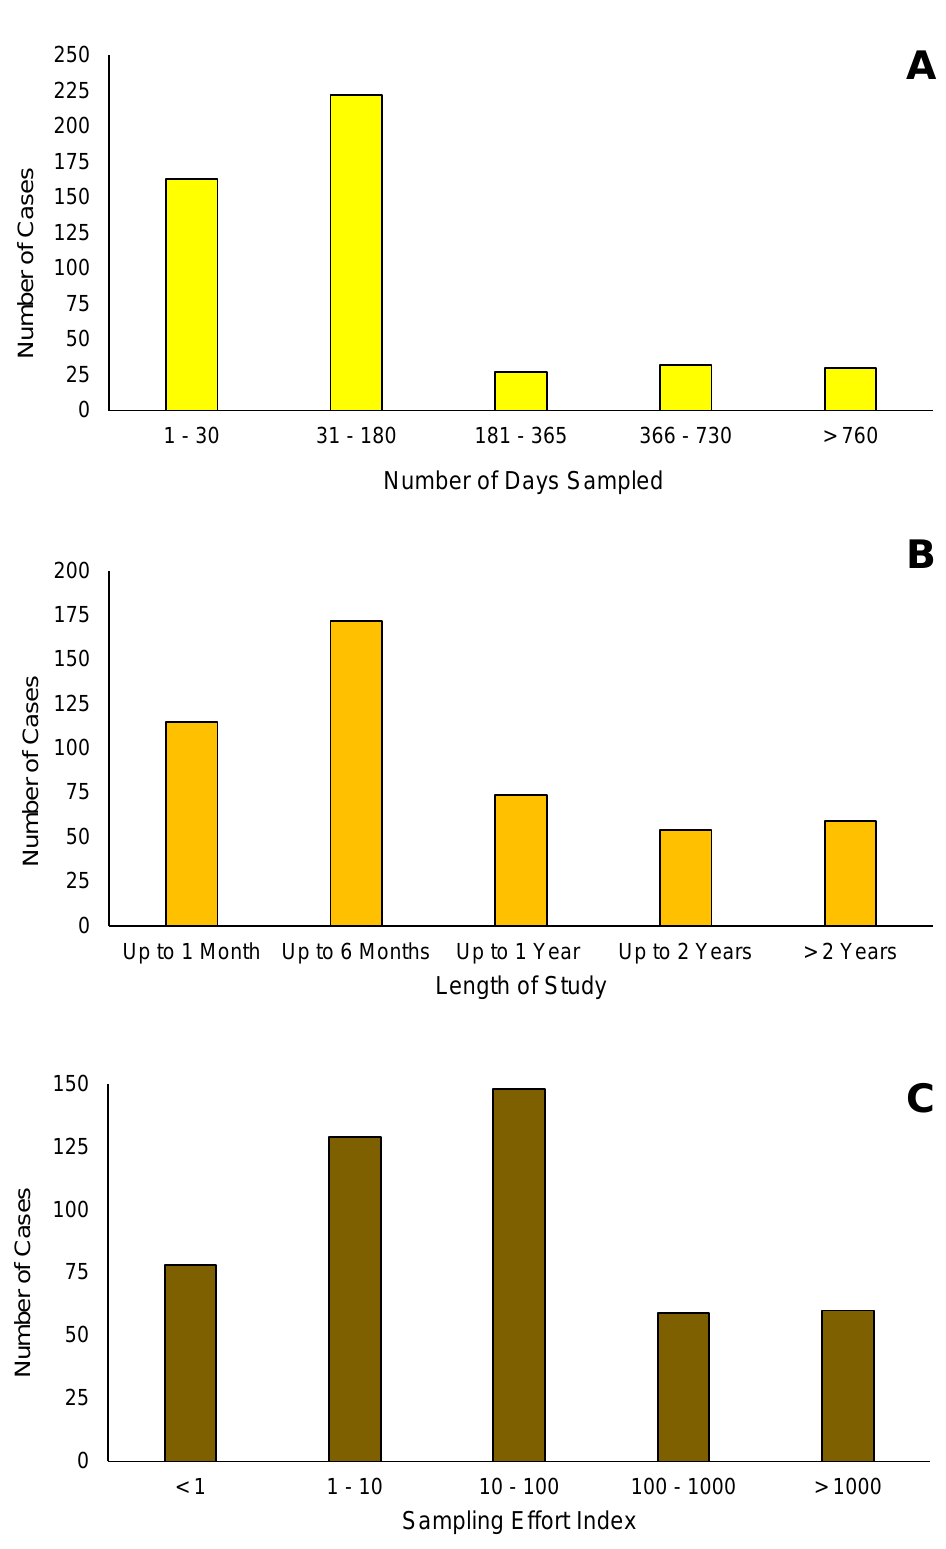
Figure 7. Total number of cases retrieved in our systematic review of the literature on in situ aerosol–PBAP research in Brazil distributed by ( A ) number of days sampled, ( B ) length of study, and ( C ) sampling effort index. Note: the sampling effort index was calculated by multiplying the number of days in which the data were collected by the length of the study (as per [23]; see Materials and Methods).